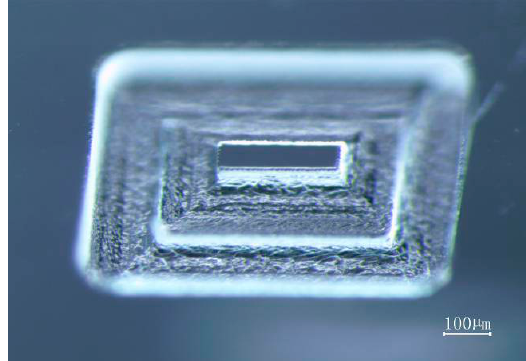
Figure 13. Three-dimensional step structure.